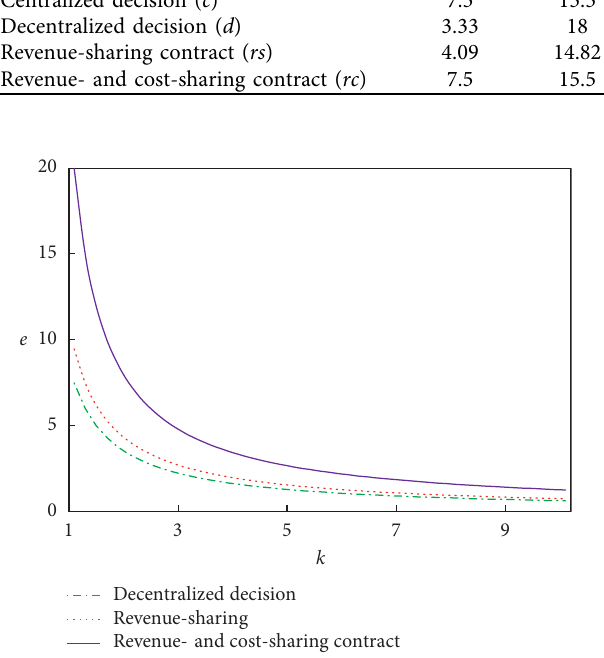
Figure 1: Effects of the safety input’s marginal cost coefficient on the work safety level.